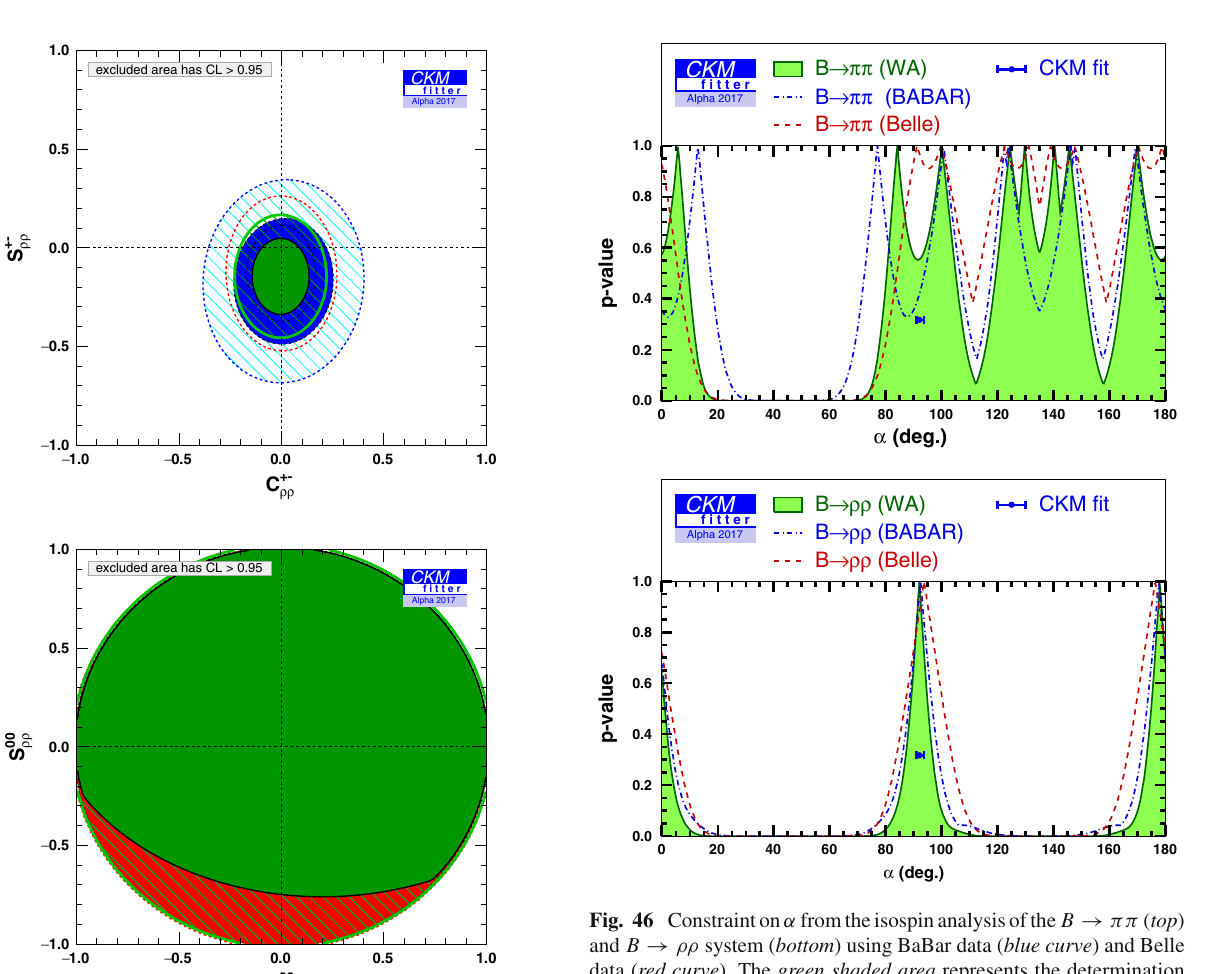
Fig. 44 Measurements of the B → ρρ branching fractions from BaBar ( blue area ) and Belle ( red area ). The LHCb contribution to the B → ρ 0 ρ 0 branching fraction is indicated by the orange area . The green shaded area represents the world average